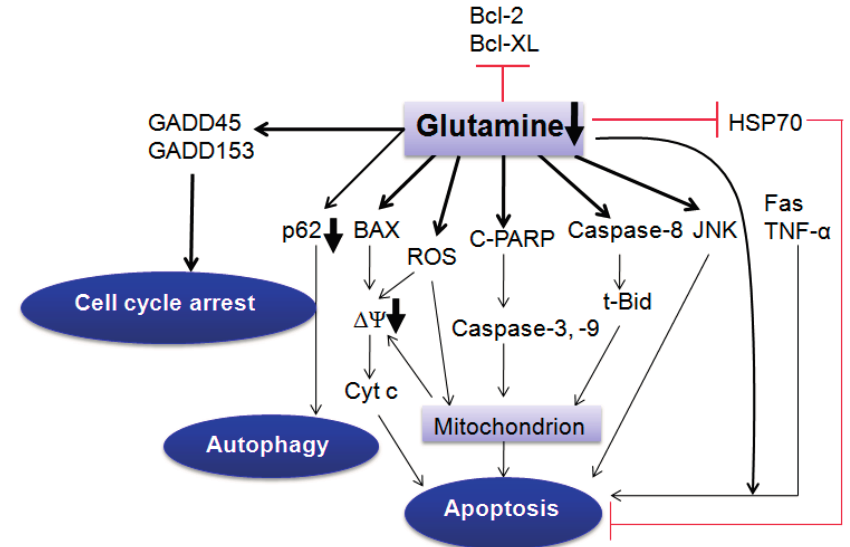
Figure 3. Glutamine deprivation induces cell death or growth arrest. Glutamine